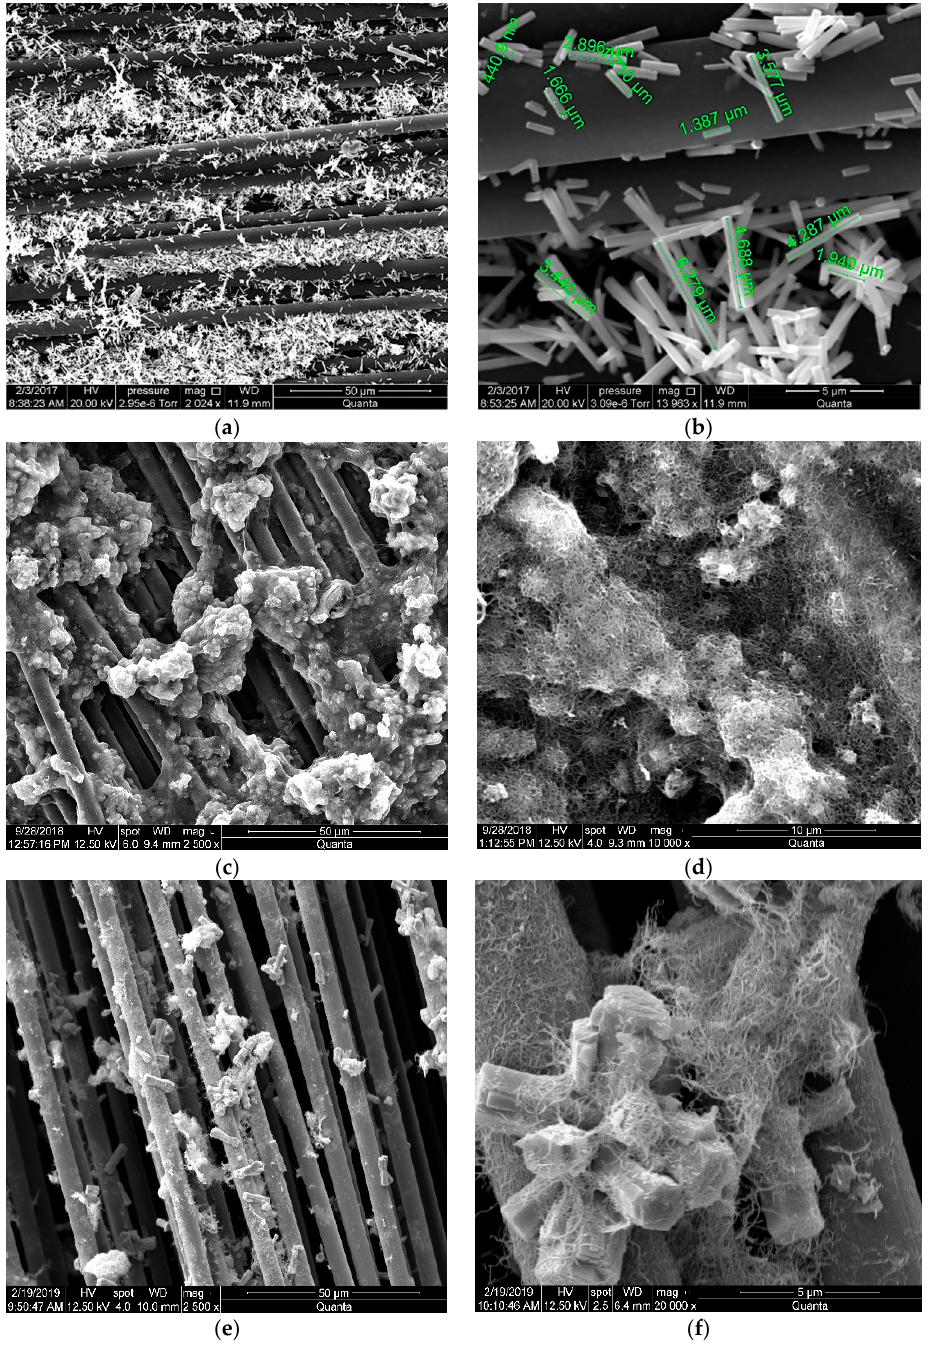
Figure 1. Scanning electron microscope (SEM) micrographs of various nanofillers on carbon fiber at different magnifications: ( a , b ) surface grown ZnO nanorods; ( c , d ) CNTs sprayed on carbon fiber; and ( e , f ) both ZnO nanorods and CNTs together.